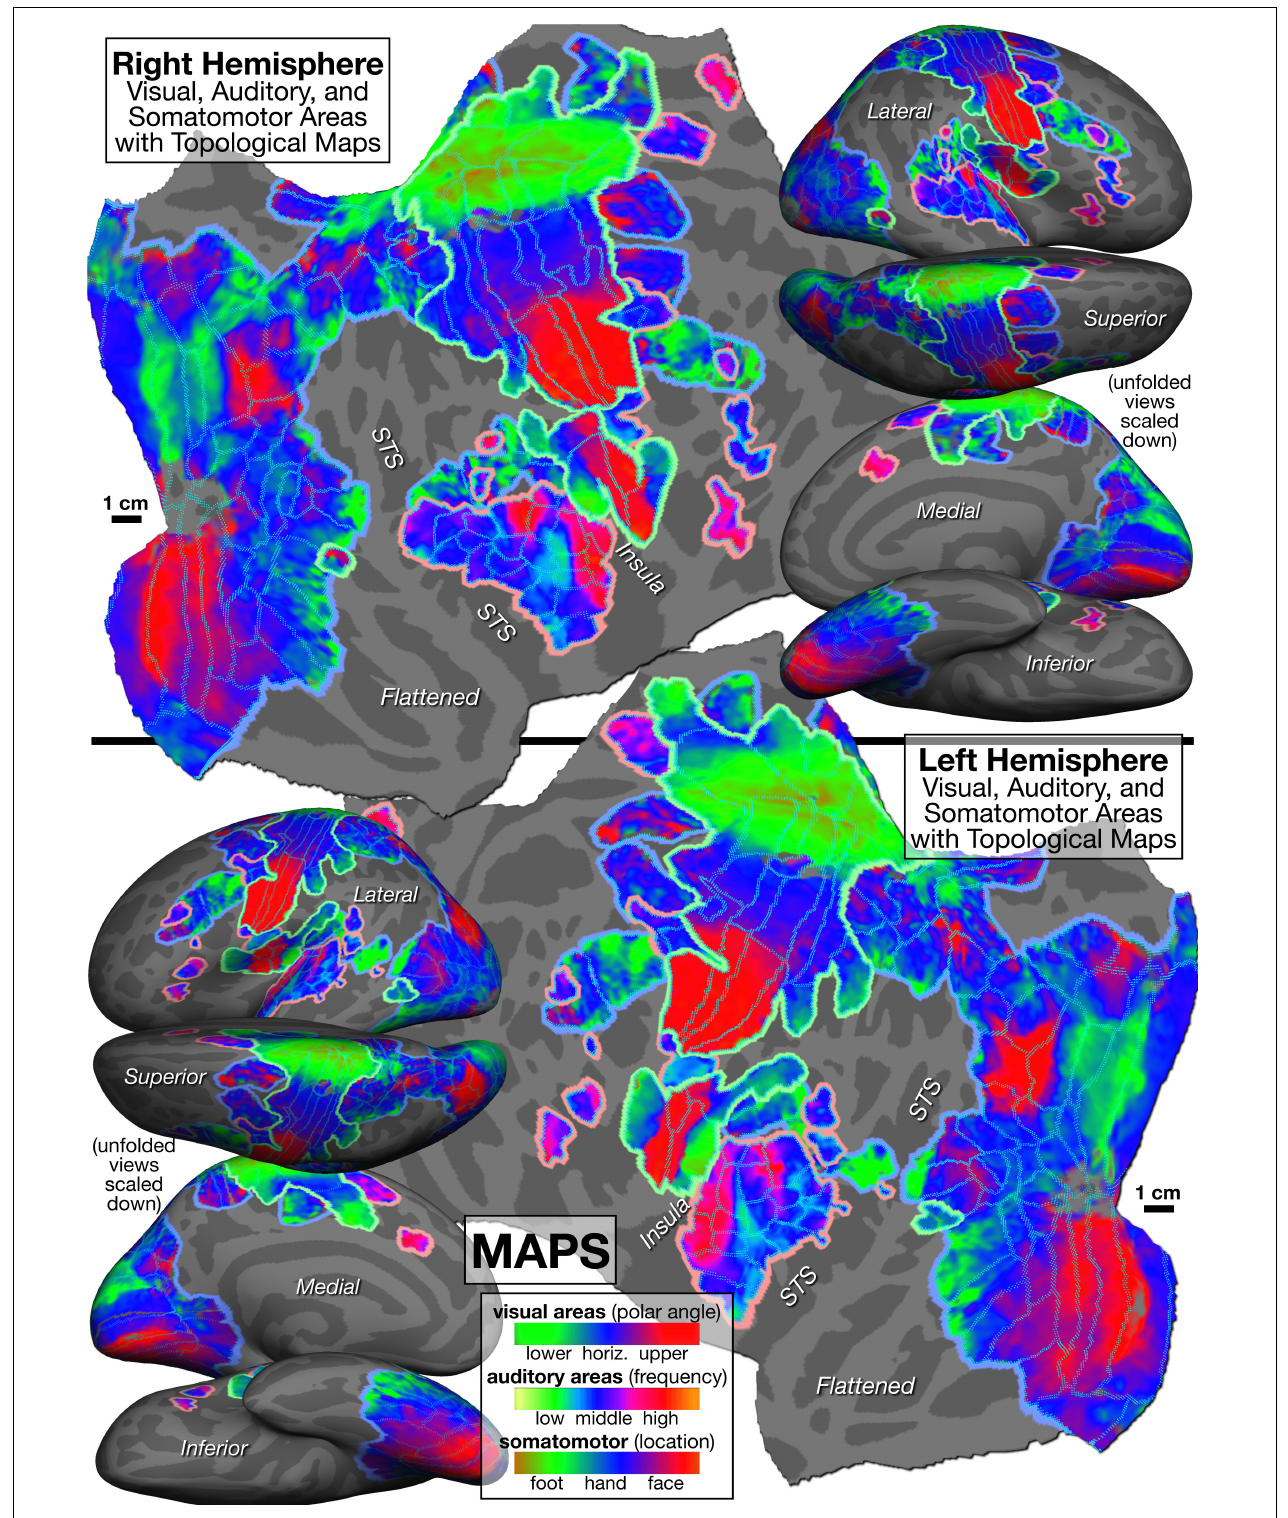
FIGURE 6 | Topological cortical maps defined by periodic response to phase-encoded mapping stimuli ( visual : clockwise/counter-clockwise rotating polar angle wedges; auditory : ascending/descending bandpass-filtered non-verbal vocalizations; somatomotor : face-to-foot/foot-to-face bilateral, cued voluntary movements of individual body parts). Green is lower field, low freq, or leg/foot; blue is horizontal meridian, mid freq, or arm/hand; red is upper field, high freq, or face.